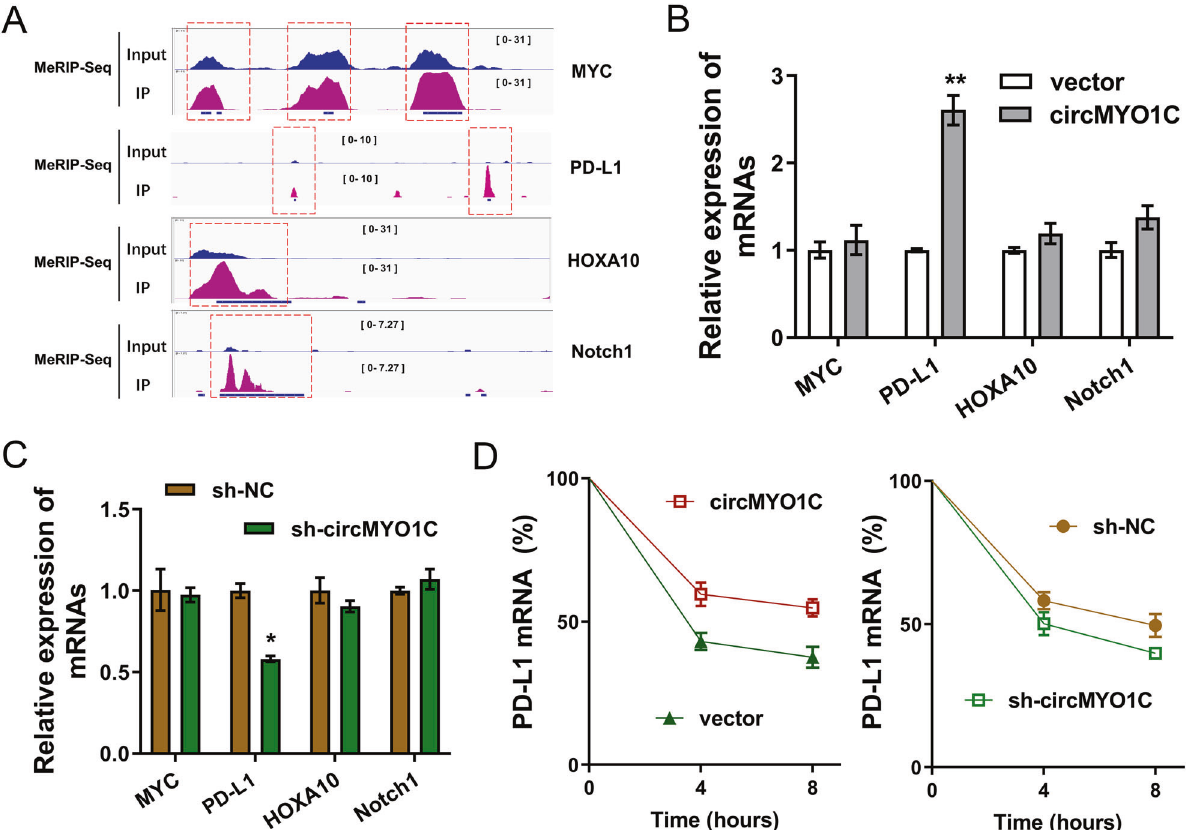
Fig. 4 circMYO1C promoted the PD-L1 mRNA stability. A IGV (Integrative Genomics Viewer, https://igv.org/) tools for the MeRIP-Seq data showed the m 6 A modi fi cation in the genomic location of several candidate genes (MYC, PD-L1, HOXA10, Notch1). RT-qPCR analysis revealed the PD-L1 mRNA level in B Capan-2 cells transfected with circMYO1C overexpression and in C PANC-1 cells transfected with sh-circMYO1. D RNA stability assay using Act D administration showed the PD-L1 mRNA level in Capan-2 cells transfected with circMYO1C overexpression and PANC-1 cells transfected with sh-circMYO1. * p < 0.05 and ** p <